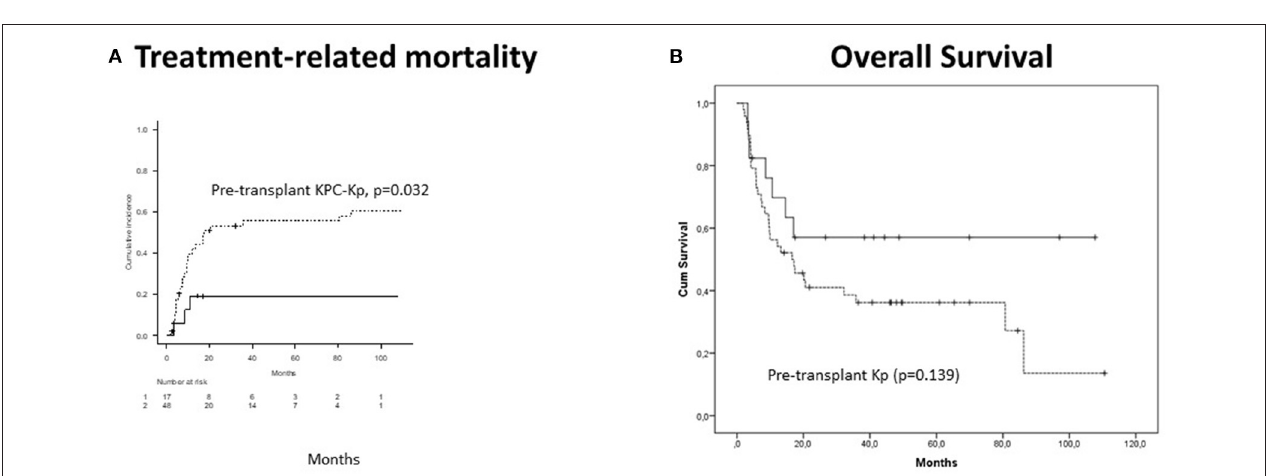
FIGURE 2 | Outcomes in patients with Kp isolates after alloHCT ( n = 66). (A) Treatment-related mortality was significantly higher in patients with pre-transplant KPC-Kp detection ( p = 0.032). (B) Overall survival was not significantly lower in patients with pre-transplant Kp detection ( p = 0.139). KP, Klebsiella pneumoniae ; KPC, Klebsiella pneumoniae carbapenemase; alloHCT, allogeneic hematopoietic cell transplantation; Cum,